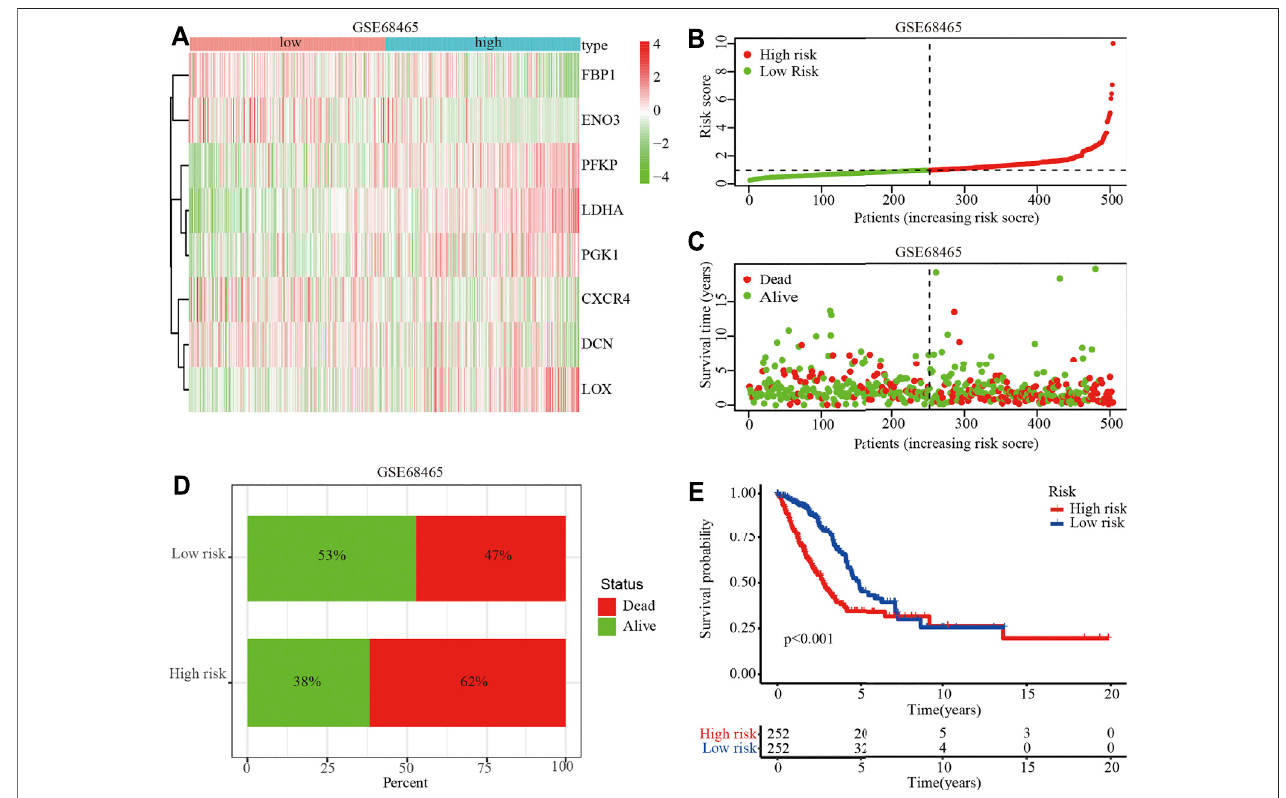
FIGURE 4 | Prognostic value of the hypoxia-related risk signature in the GSE68465 dataset. (A) Heatmap of high- and low-risk LUAD patients strati fi ed by eight hypoxiarelated keygenesin GSE68465 dataset (B) Distribution and median survival time ofhigh- and low-risk LUADpatientsin the GSE68465 dataset. (C) Distribution of high- and low-risk LUAD patients. (D) Survival and mortality in the high- and low-risk LUAD patients. (E) OS analysis of high- or low-risk LUAD